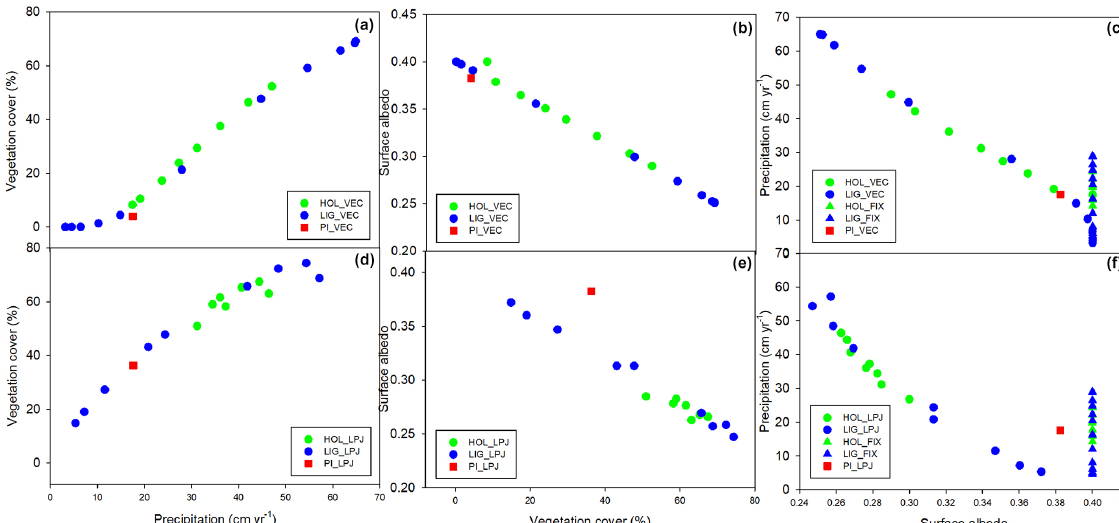
Figure 5. The relationship between (a) precipitation and vegetation cover; (b) vegetation cover and surface albedo; (c) surface albedo and precipitation with dynamical vegetation from VECODE during two interglacials; (d) precipitation and vegetation cover; (e) vegetation cover and surface albedo; (f) surface albedo and precipitation with dynamical vegetation from LPJ-GUESS during two interglacials.